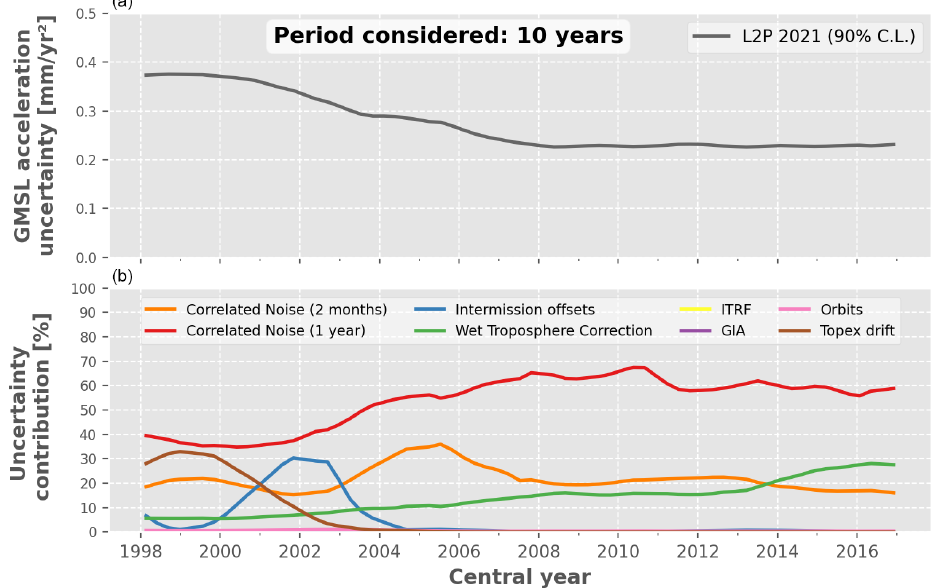
Figure 10. Relative contribution of each uncertainty budget contributor to the GMSL acceleration uncertainty over periods of 10 years. (a) GMSL acceleration uncertainty in the L2P21 record. ( (b) Relative contribution to the total GMSL acceleration uncertainty (%) of each uncertainty budget contributor, i.e. the altimeters, the radiometers, the orbit determination and the geophysical corrections.